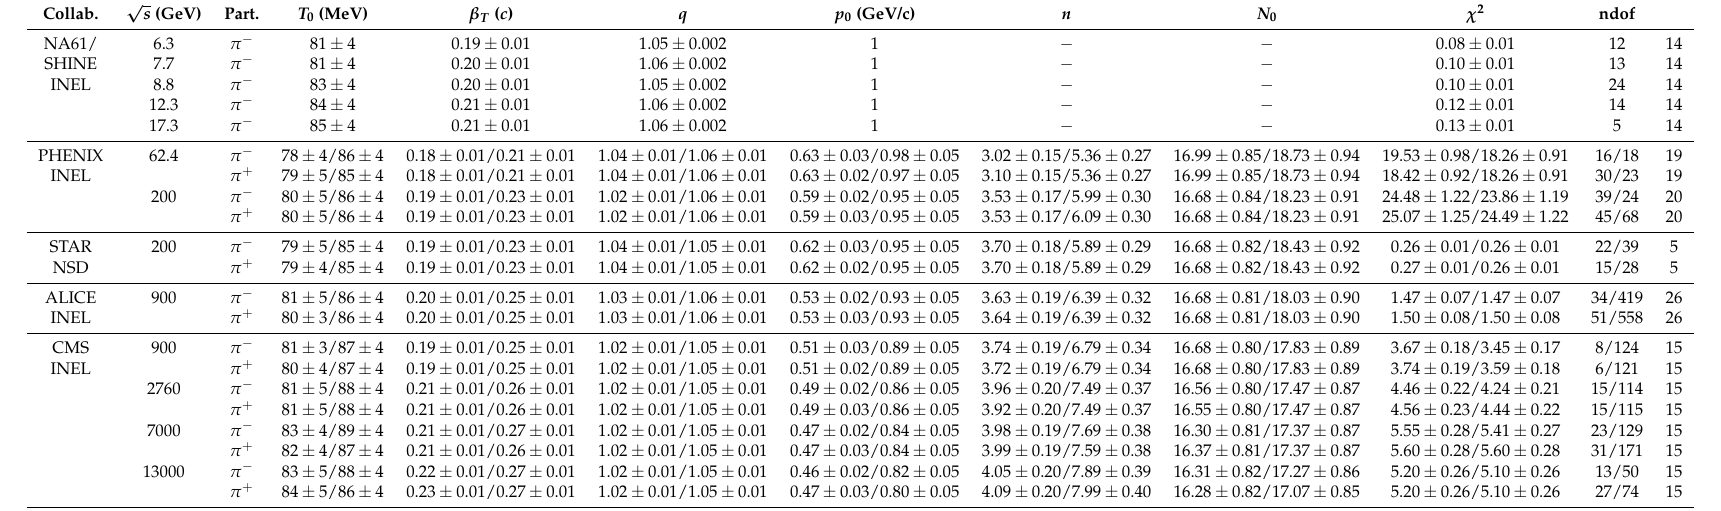
Table 2. Values of free parameters ( T 0 , β T , q k , p 0 , and n ), normalization constant ( N 0 ), χ 2 , and ndof corresponding to the dashed (dot-dashed) curves for π − ( π + ) spectra in Figure 1 in which different data are measured in different mid-(pseudo)rapidity intervals at different energies by different Collaborations. The values presented in terms of value 1 /value 2 denote respectively the first and second sets of parameter values in Equation (7) through Equations (2) and (3) in which k (cid:54) = 1. √ s (GeV) Collab.